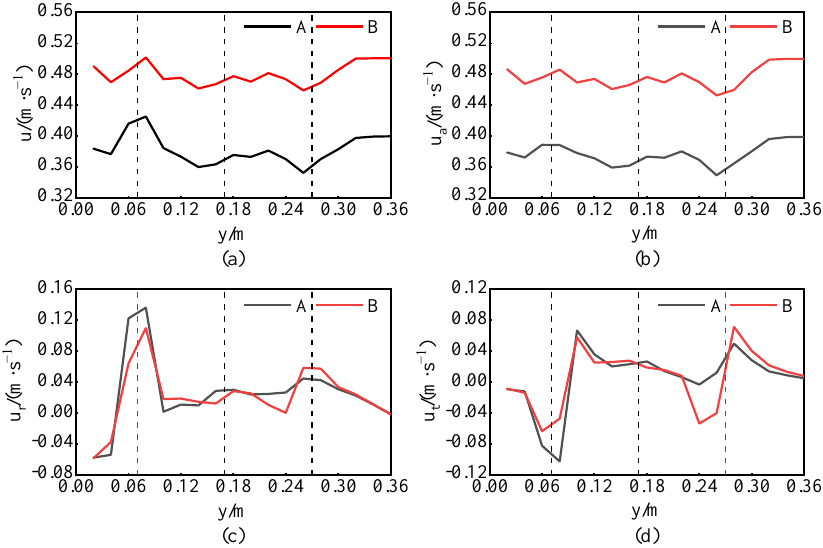
Figure 13. Velocity distribution at the radial position r = 90 mm when the medium is water and Re = 44,910. The three dotted lines are the centerline positions of the three blades. ( a ) Total speed comparison; ( b ) Axial velocity comparison; ( c ) Radial velocity comparison; ( d )Tangential velocity comparison.